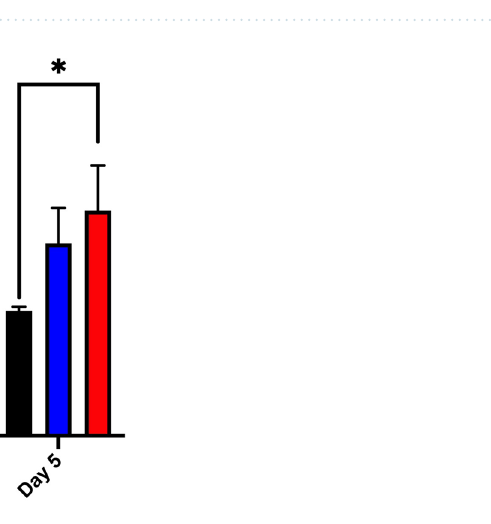
Figure 5. SEM image. ( a ) PEEK particles at low magnification, ( b ) PEEK particles at high magnification, ( c and d ) ADCNCs/SF/PEEK hydrogel; ( e ) Human Dental Pulp Stem Cells on fabricated hydrogels.